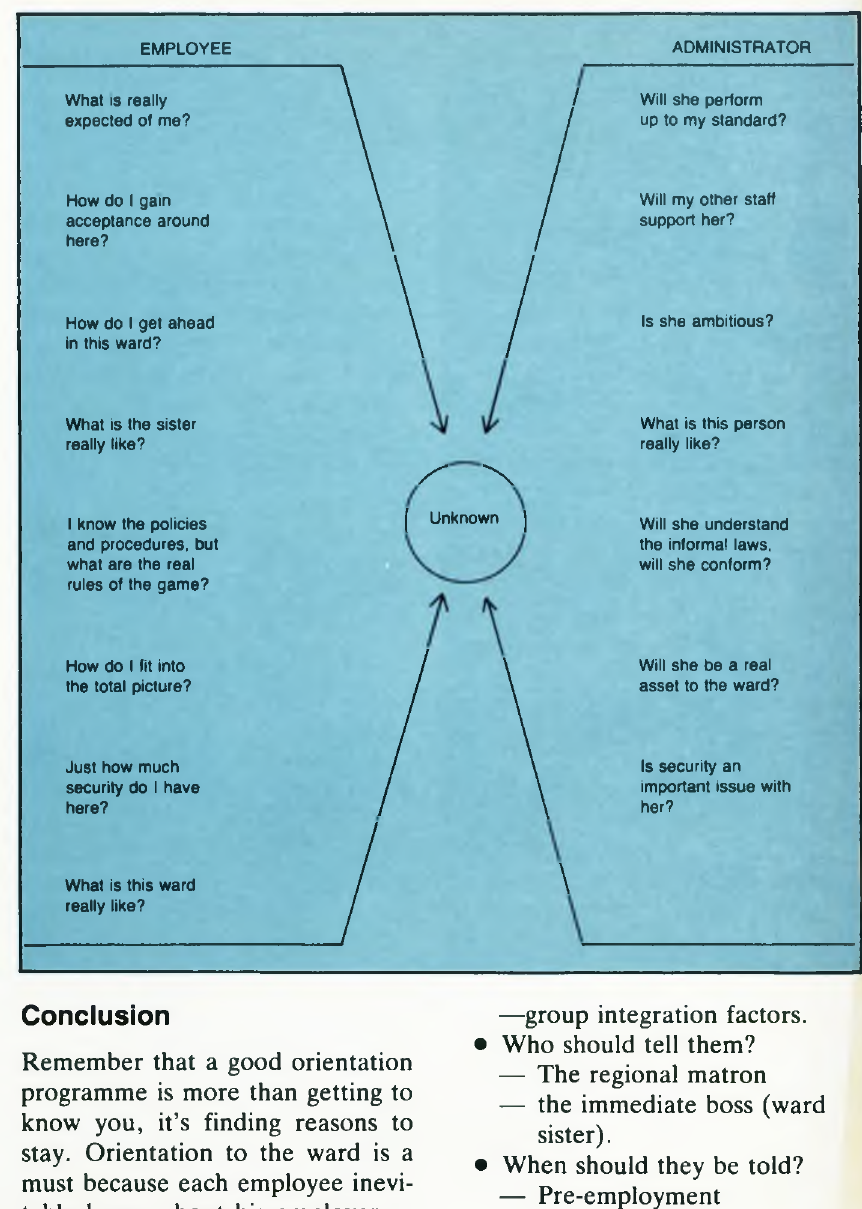
Figure 1: Questions in the new employee/employer